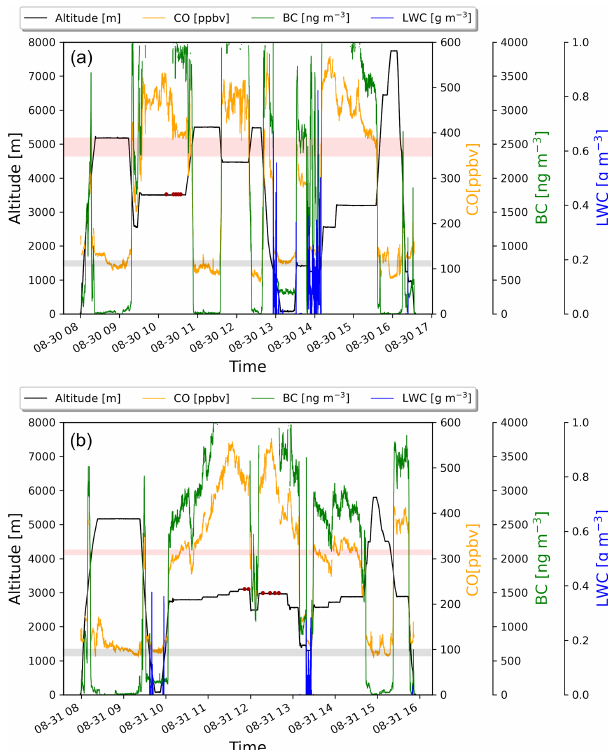
Figure 2. (a) Time series of RF 11, together with the aircraft altitude (black line), carbon monoxide (yellow line), black carbon (green line), cloud liquid water content (blue line), height range of the top of the biomass burning plume (pink bar), height range of the top of the stratocumulus deck (gray bar), and locations where SAPs were observed (red dots). (b) Same as (a) but for RF 12.